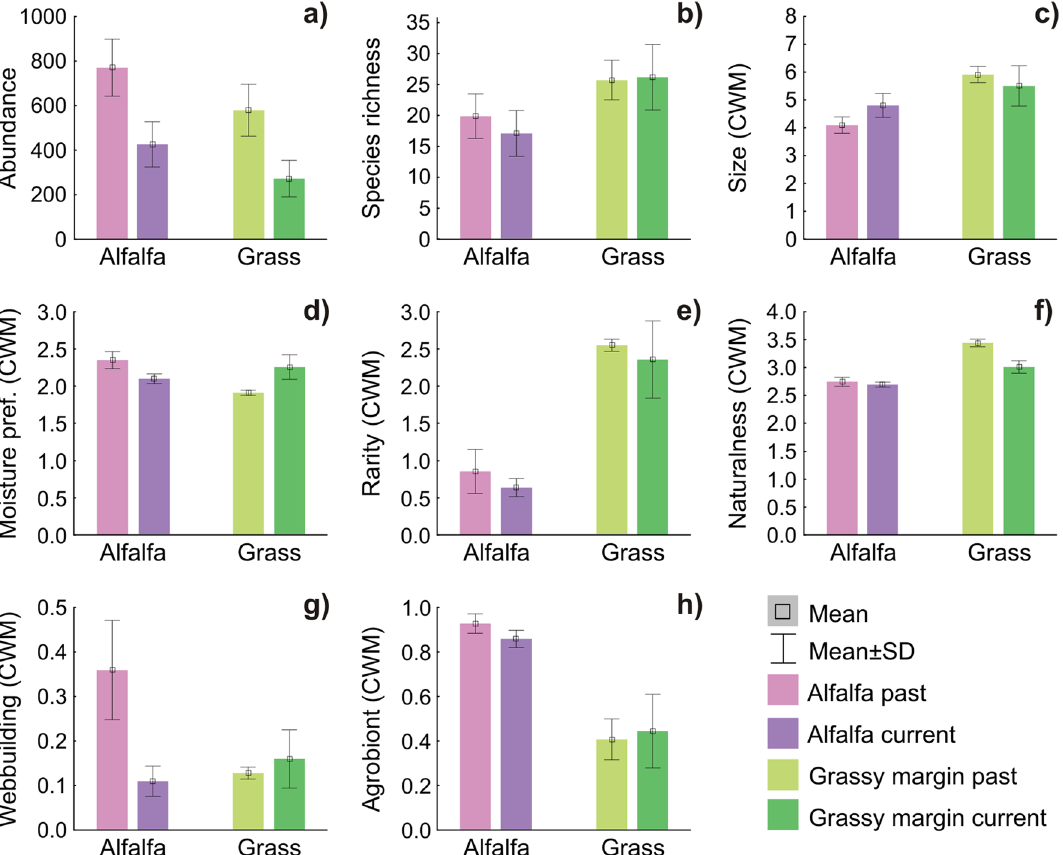
Figure 2. Habitat type and sampling period affect spiders (mean ± SD). Darker shades represent the current period; lighter shades indicate the past sampling period. ( a ) total abundance, ( b ) species richness, ( c ) CWM of spider size, ( d ) CWM of moisture preference, ( e ) CWM of rarity, ( f ) CWM of naturalness; ( g ) CWM of web building hunting strategy; ( h ) CWM of agrobiont status. Refer to Table 2 for further details.